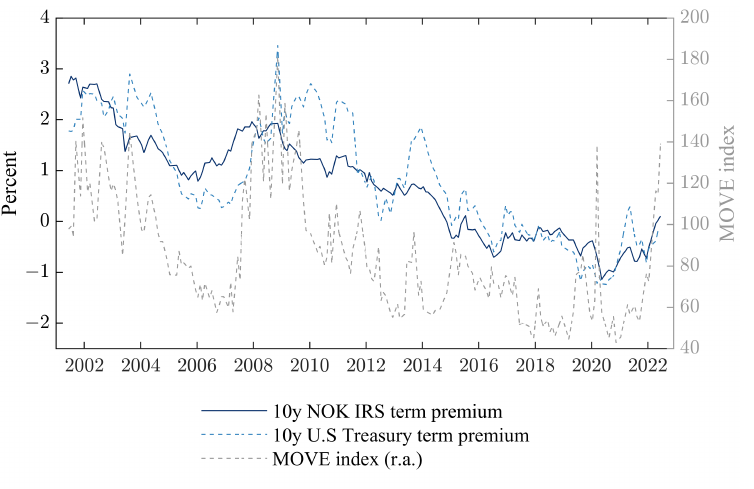
Figure 3. ACM 10 y term premia (left axis) vs. MOVE (right axis). NOK IRS estimates by the authors, U.S. estimates as reported by the Federal Reserve Bank of New York and MOVE Index retrieved from Bloomberg. Sample period: 2001/04 to